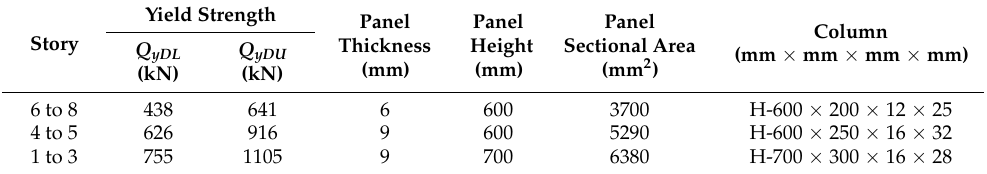
Table A2. Steel damper columns for 8-story model.